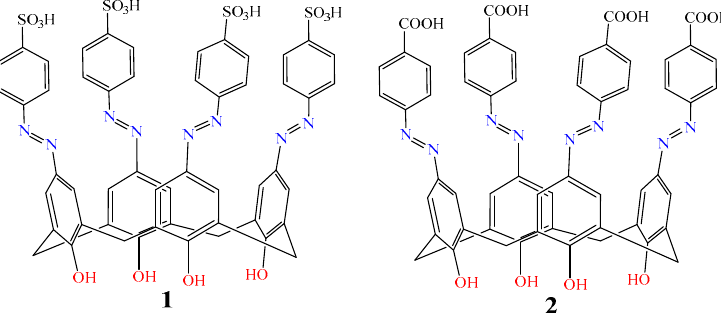
Figure 1. Structures of calix[4]arenes 1, 2 functionalized with azo groups on the upper rims [34].